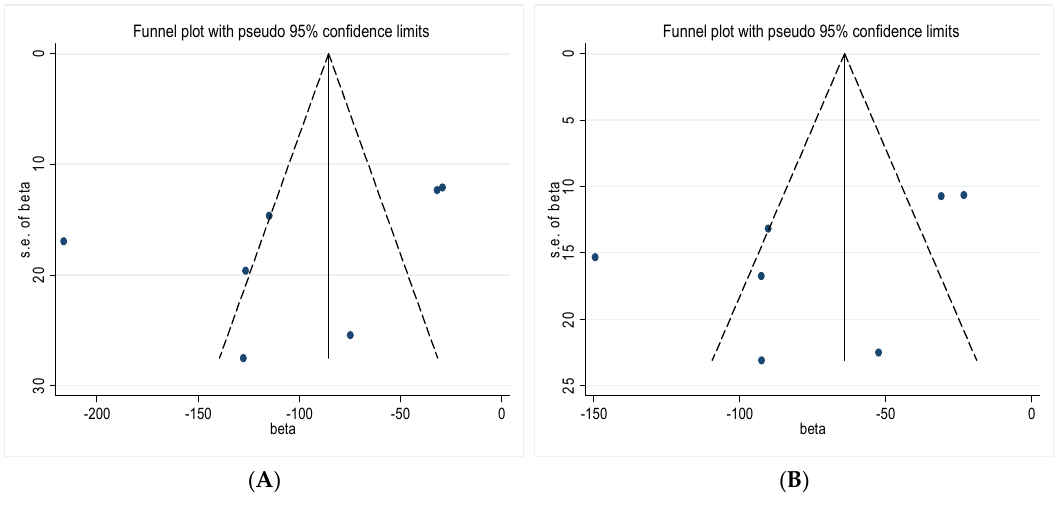
Funnel plot with pseudo 95% confidence limits Figure 5. Cont